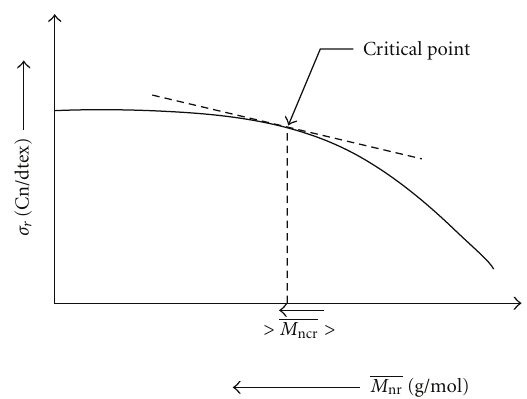
Figure 21: Theoretical relationship between macromolecular weight and breaking stress